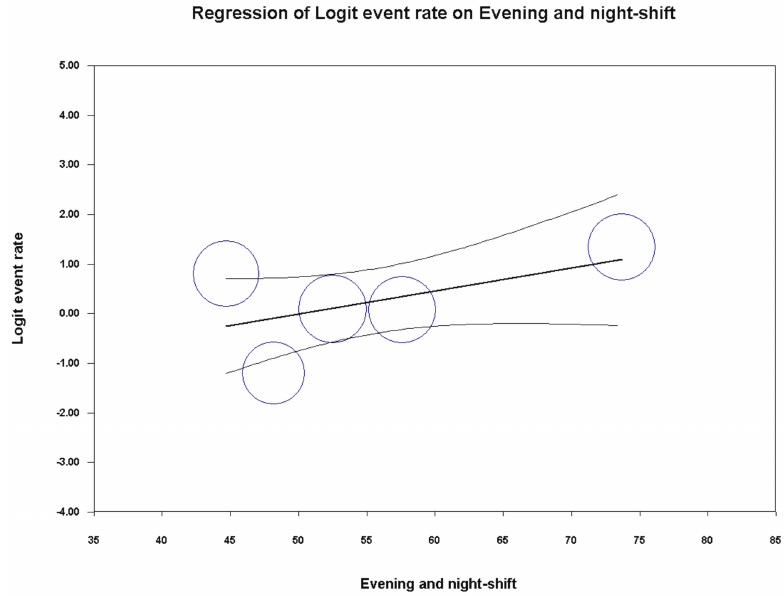
Figure 5. Meta-regression analysis showing a statistically borderline association between prevalence of low sleep quality in police officers and percentage of police officers on evening/night